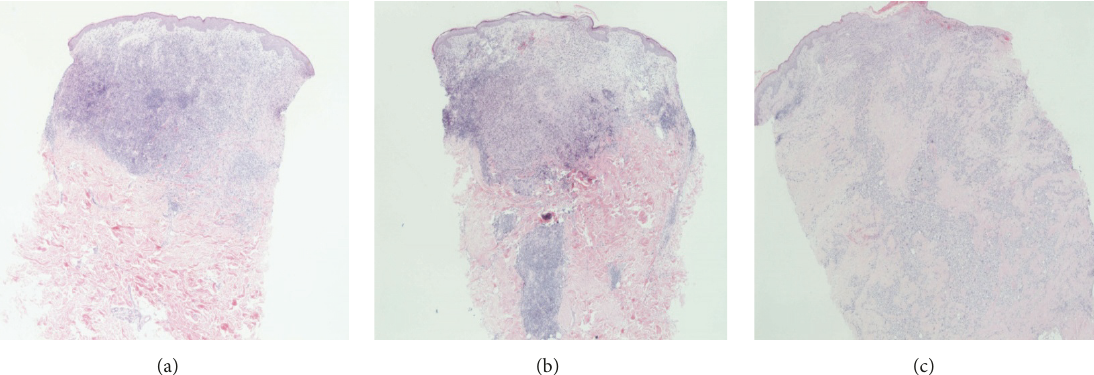
Figure 1: Low power H&E images demonstrating variable amount of inflammatory infiltrate around tumour cells and extending into the subcutaneous tissue in each of the three biopsies (a), (b), and (c).